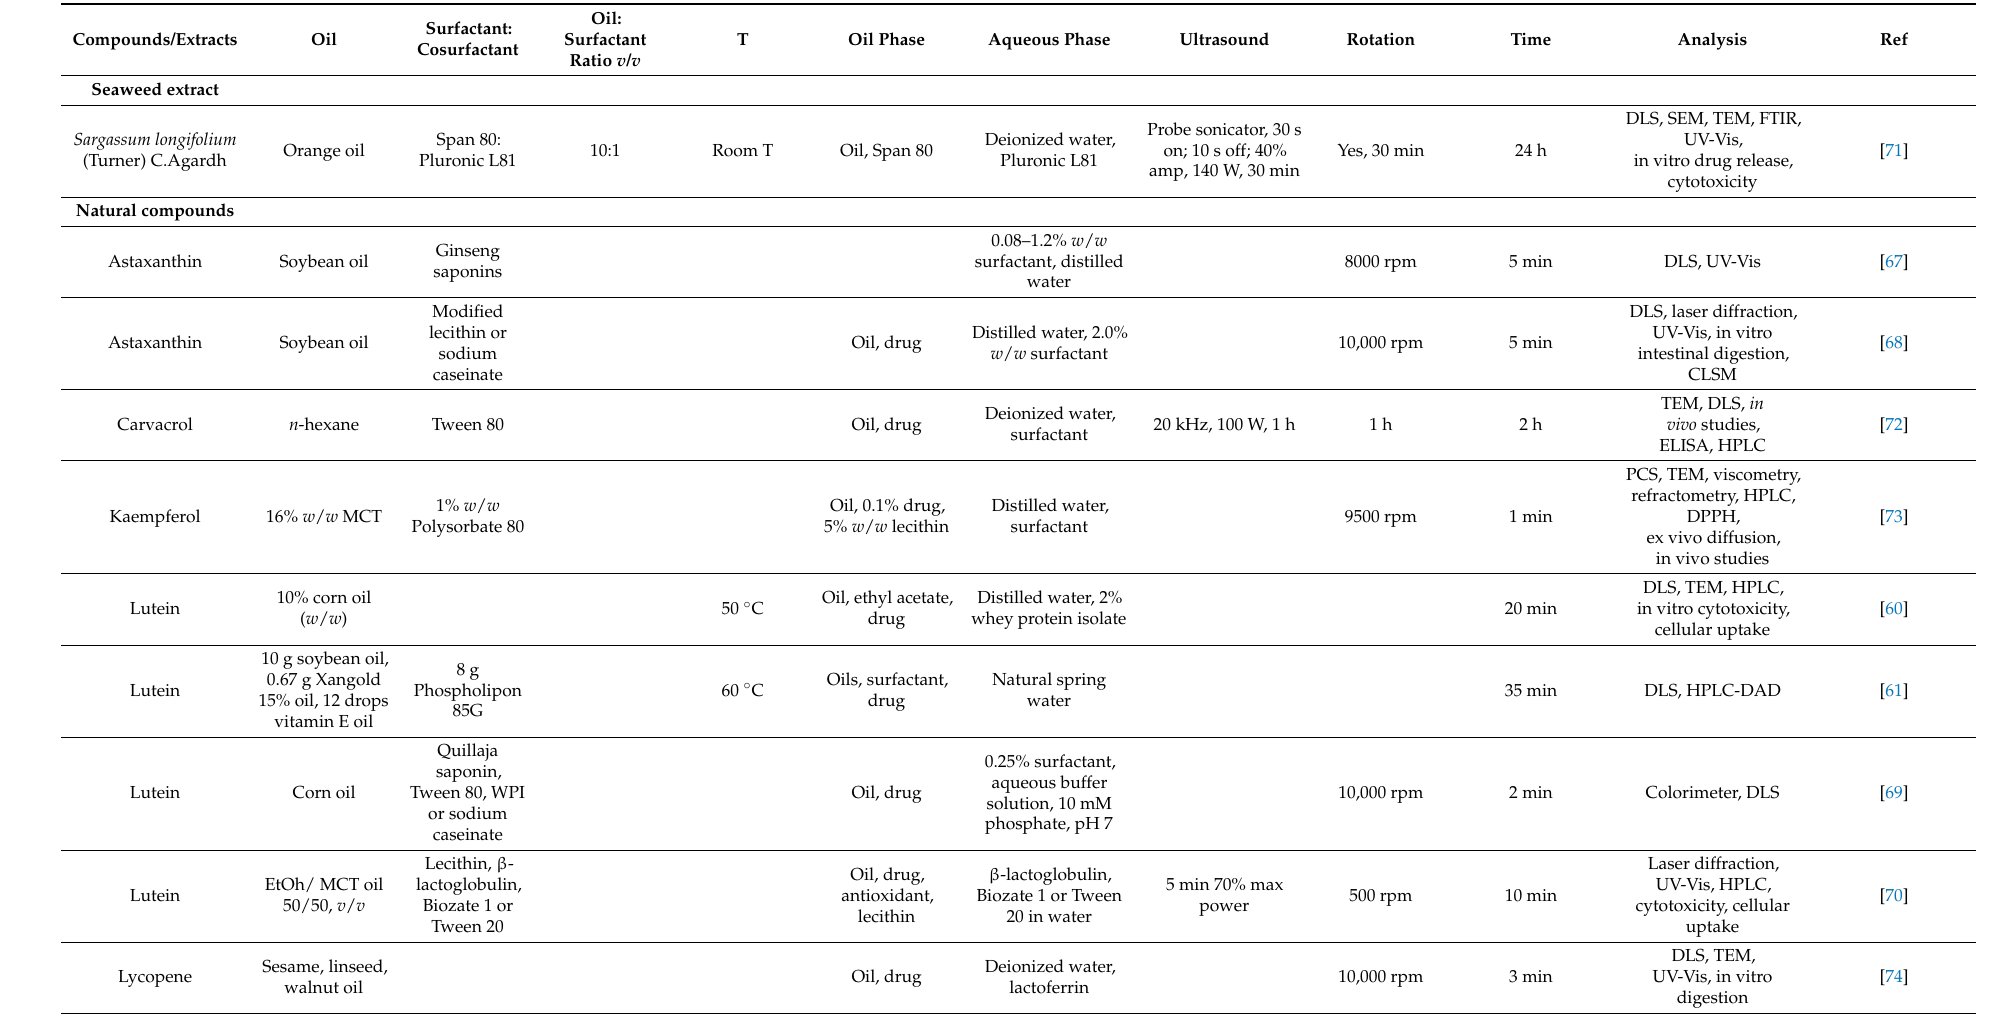
Table 1. Nanoemulsions produced to encapsulate neuroprotective compounds and